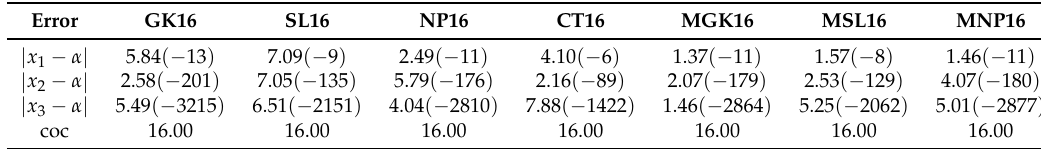
Table 5. Numerical results for f 3 , x 0 = − 1.25.